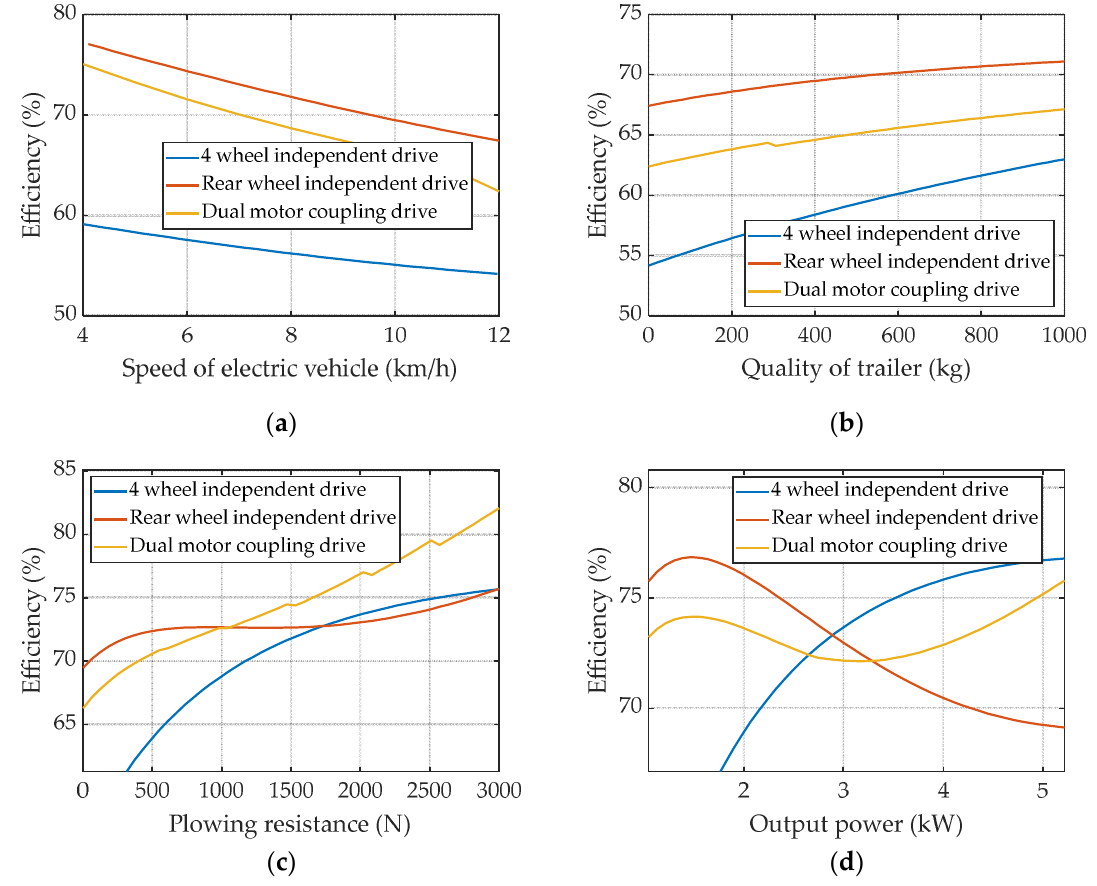
Figure 16. Estimation results of full vehicle efficiency of tractor in four working conditions. ( a ) Working condition of constant-speed running; ( b ) Working condition of transportation; ( c ) Work- ing condition of ploughing; ( d ) Working condition of rotary tillage.